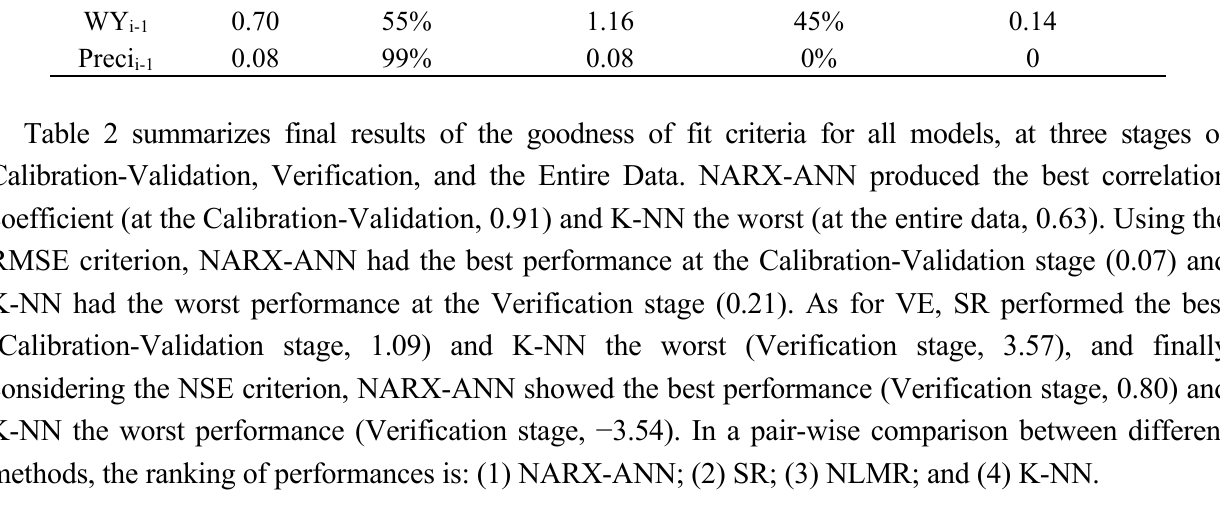
Table 2. Performance statistics for the tested data-driven